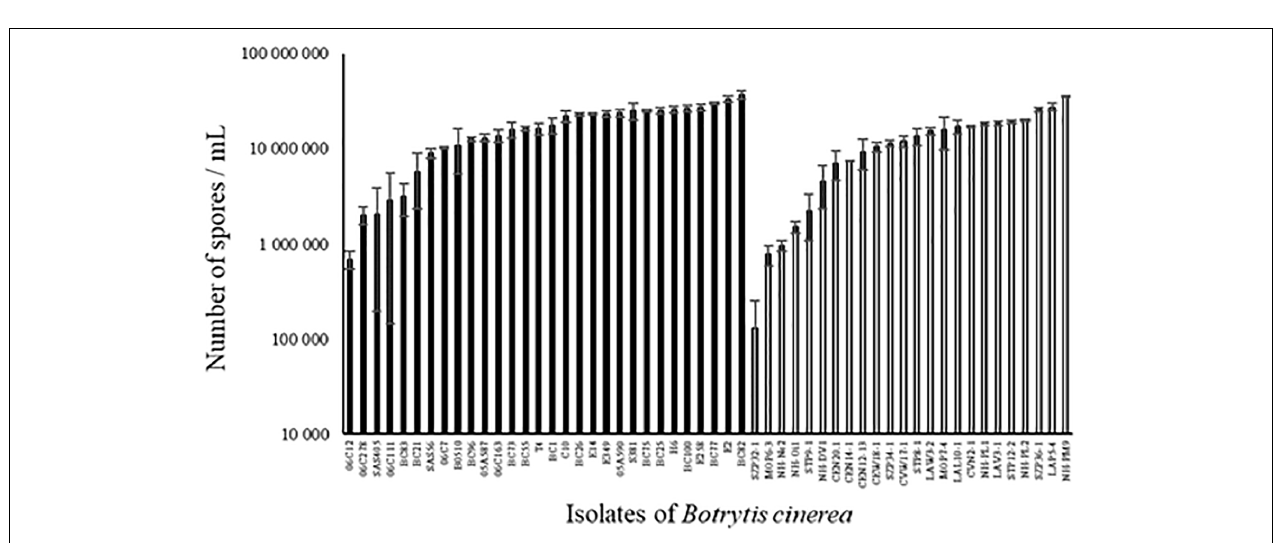
FIGURE 4 | Number of spores produced on PDA medium after 14 days of incubation in controlled condition (21 ◦ C, photoperiod 14 h, 114 µ mol m − 2 s − 1 ) by 30 agricultural (black) and 24 environmental (white) strains of B. cinerea . Each value represents the mean of three replicates. The vertical bar associated to each histogram correspond to